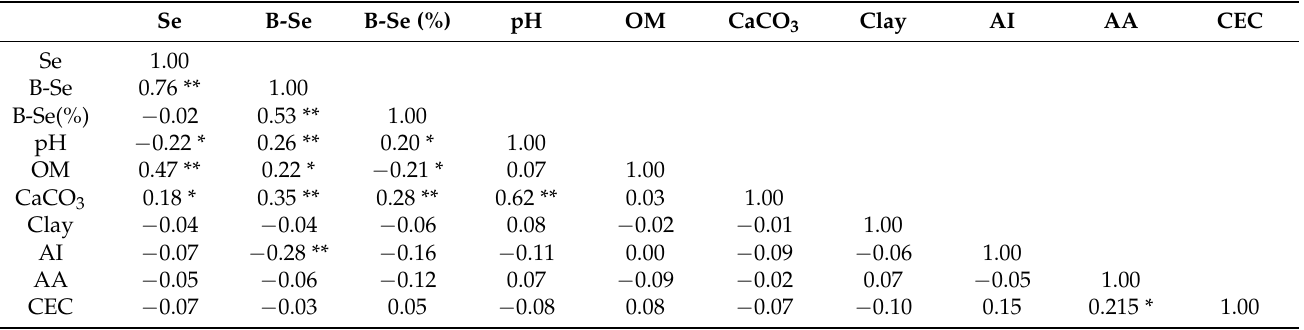
Table 2. Matrix of correlations of bioavailable Se and controlling factors in